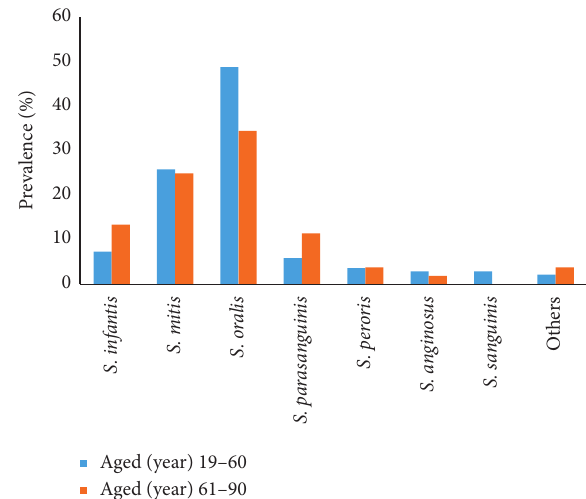
Figure 1: Prevalence of viridans group isolates isolated from adult patients with age 19 to 60 years (blue bar) and adult patients with age above 60 years (orange bar).